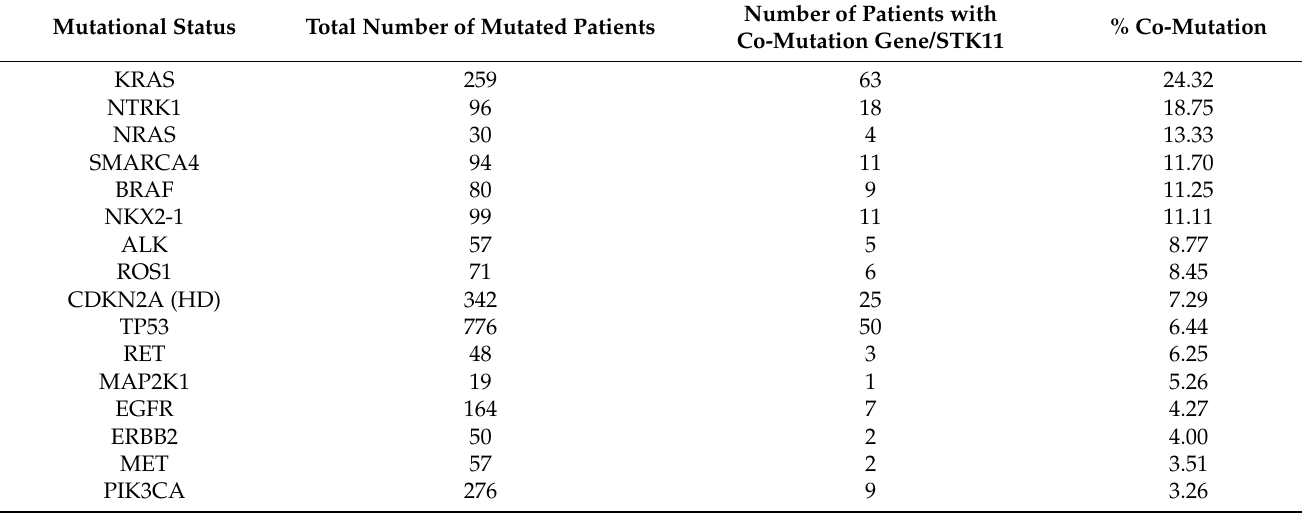
Table 1. Frequency of STK11 mutation in each mutational status in NSCLC. TCGA. Nat Genet 2016. 1144 samples. HD: homozygous deletion) from https://www.cbioportal.org/ (accessed on 1 October 2021). Mutational Status Total Number of Mutated Patients